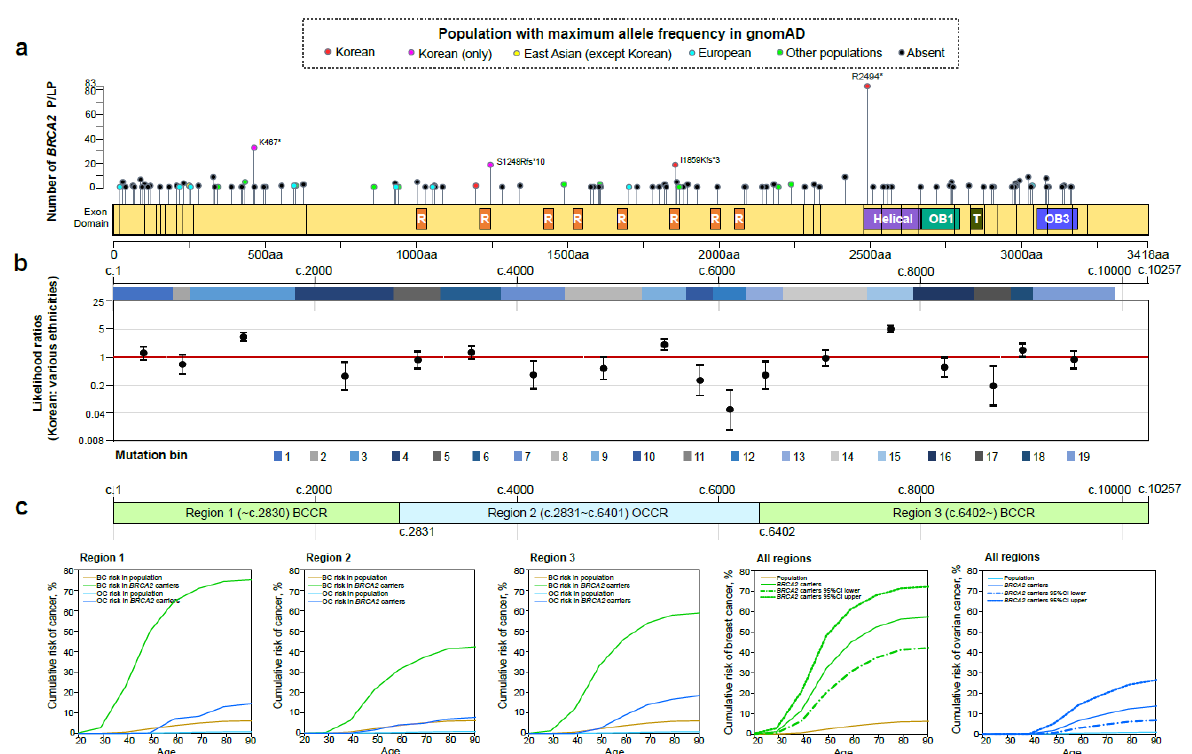
Figure 4. Analysis of pathogenic or likely pathogenic variants in BRCA2 . ( a ) Distribution of pathogenic or likely pathogenic variants (PLPVs) in BRCA2 in the Korean BRCA cohort. ( b ) Comparative analysis of the proportion of BRCA2 PLPVs found in every mutation bin between the Korean BRCA and large-scale cohort. The 19 mutation bins across the span of the coding DNA sequence of BRCA2 were constructed using an algorithm in which each mutation bin contained approximately equal numbers of BRCA2 PLPVs in a previous study [21]. ( c ) Estimation of cumulative risks of breast and ovarian cancers for BRCA2 carriers by mutation regions: region 1 (5′ to c.2830, breast cancer cluster regions (BCCR)), region 2 (c.2831 to c.6401, ovarian cancer cluster regions (OCCR)), and region 3 (c.6402 to 3′, BCCR) [21,22]. R, BRCA2 repeat (1002–1035, 1213–1245,